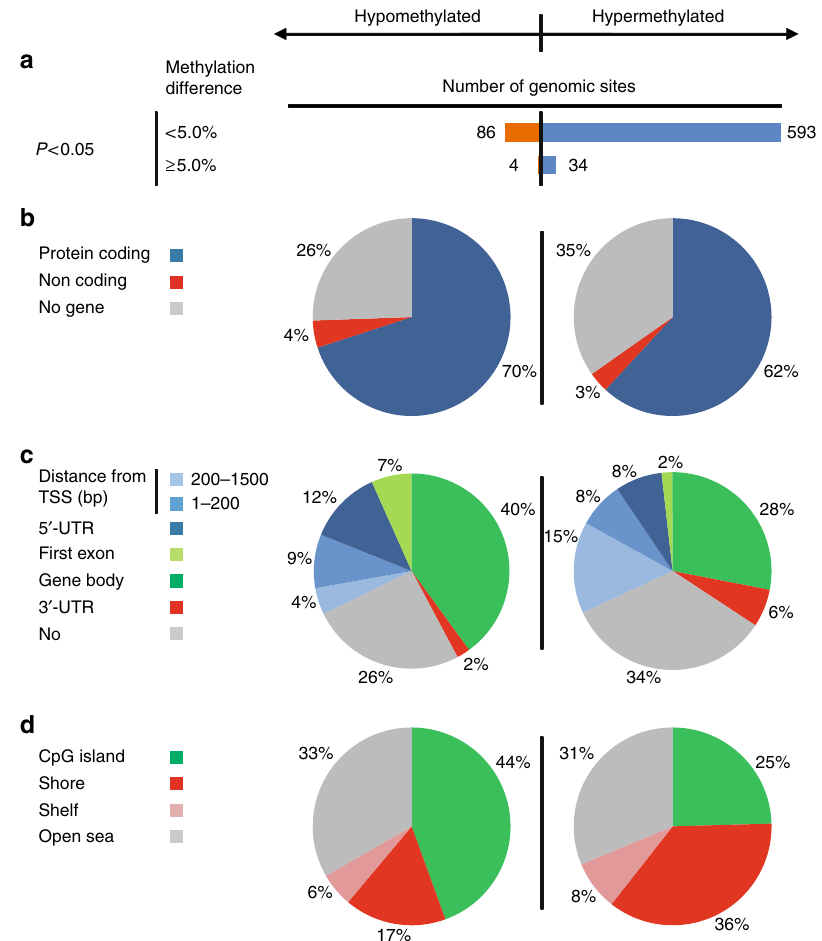
Fig. 1 Epigenome-wide methylation analysis. a – d CpG sites hypo- and hypermethylated in n = 94 PSP patients vs. n = 71 controls are displayed on the left and right panels, respectively. a Number of genomic sites aberrantly methylated at a difference of < 5% and ≥ 5% between patients and controls (Benjamini-Hochberg corrected P < 0.05). b Location of aberrantly methylated sites within protein-coding genes, non-coding genes and intergenic regions. c Location of aberrantly methylated CpG sites in relation to de fi ned regions of genes (TSS: transcription start site; 5´and 3´UTR: 5 ′ and 3 ′ untranslated region). d Association of aberrantly methylated sites with CpG islands (shores are < 2 kb and shelves are 2 – 4 kb from a CpG